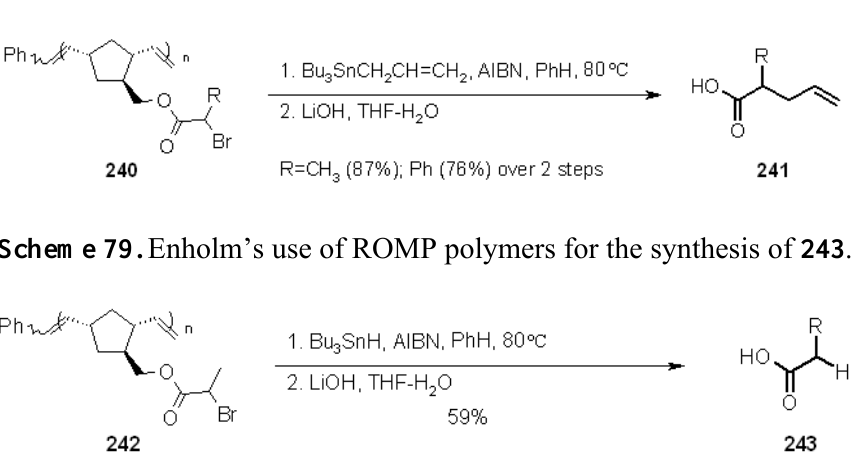
Scheme 80. Enholm’s use of ROMP polymers for the synthesis of 245